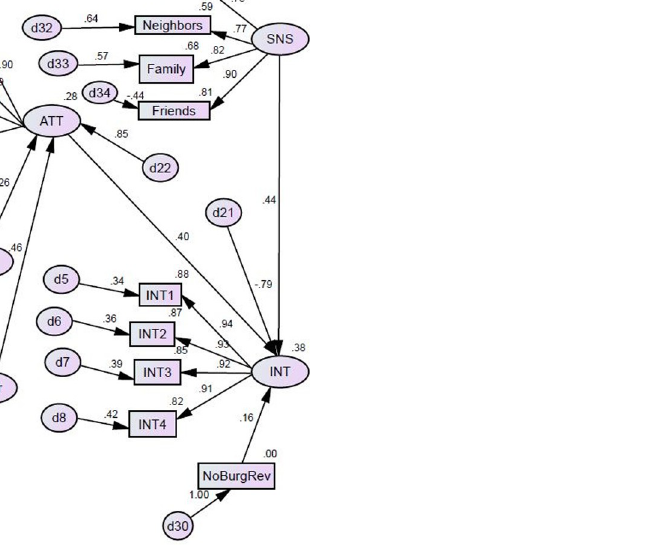
Fig 3. Evaluated TRA structural